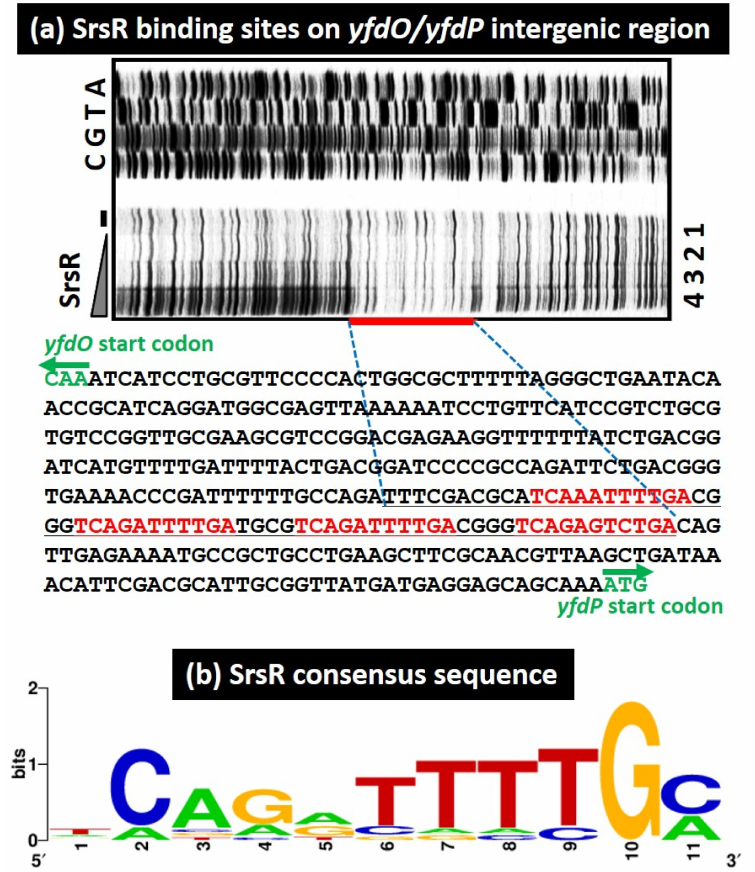
Figure 3. SrsR binding sequence. ( a ) DNase-I footprinting assay for identifying the SrsR binding site on the yfdP/yfdO intergenic region. Mixtures of FITC-labeled DNA probe (1.0 pmol) of the yfdP/yfdO spacer sequence and increasing amounts of purified SrsR (0, 10, 20, 40 µ M) were subjected to the DNase-I treatment. The sequence shown includes those between the initiation codon of the yfdO gene and the initiation codon of the yfdP gene. The red bar indicates the DNase-I protected region (SrsR box) by SrsR. The DNase-I protected region by SrsR is shown in black. ( b ) Consensus sequence of the SrsR box. Sequences of all the probes with high-level binding of SrsR were analyzed using THE MEME Suite (Available online: https://meme-suite.org/meme/ (accessed on 1 June 2021)) (see Table 1). WEBLOGO (Available online: http://weblogo.berkeley.edu/logo.cgi (accessed on 1 June 2021)) was used to perform matrix